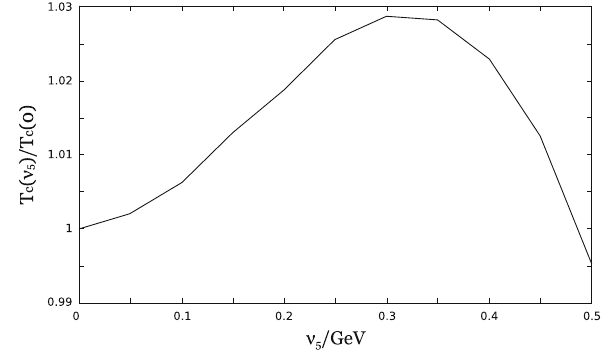
Fig. 9 Pseudo-critical temperature T c (ν 5 ) (35) as a function of ν 5 where this region is arranged around the dashed lines). It sep- arates the low-temperature phase with CSB and a (partially) chirally restored ApprSYM phase, which corresponds at high temperatures to quark-gluon plasma. In the cross-over region different physical parameters, such as the dynamical quark mass M 0 etc, of the CSB phase smoothly (without jumps), but rather sharply go over to the corresponding parameters of the ApprSYM phase. Therefore, in this region, there occurs not a true phase transition with corresponding critical temperature, etc., but rather a pseudo -phase transition (cross-over) charac- terized by a pseudo -critical temperature T c ≡ T c (μ, ν, ν 5 ) , etc. (In Figs. 7, 8 the pseudo-critical temperature T c is